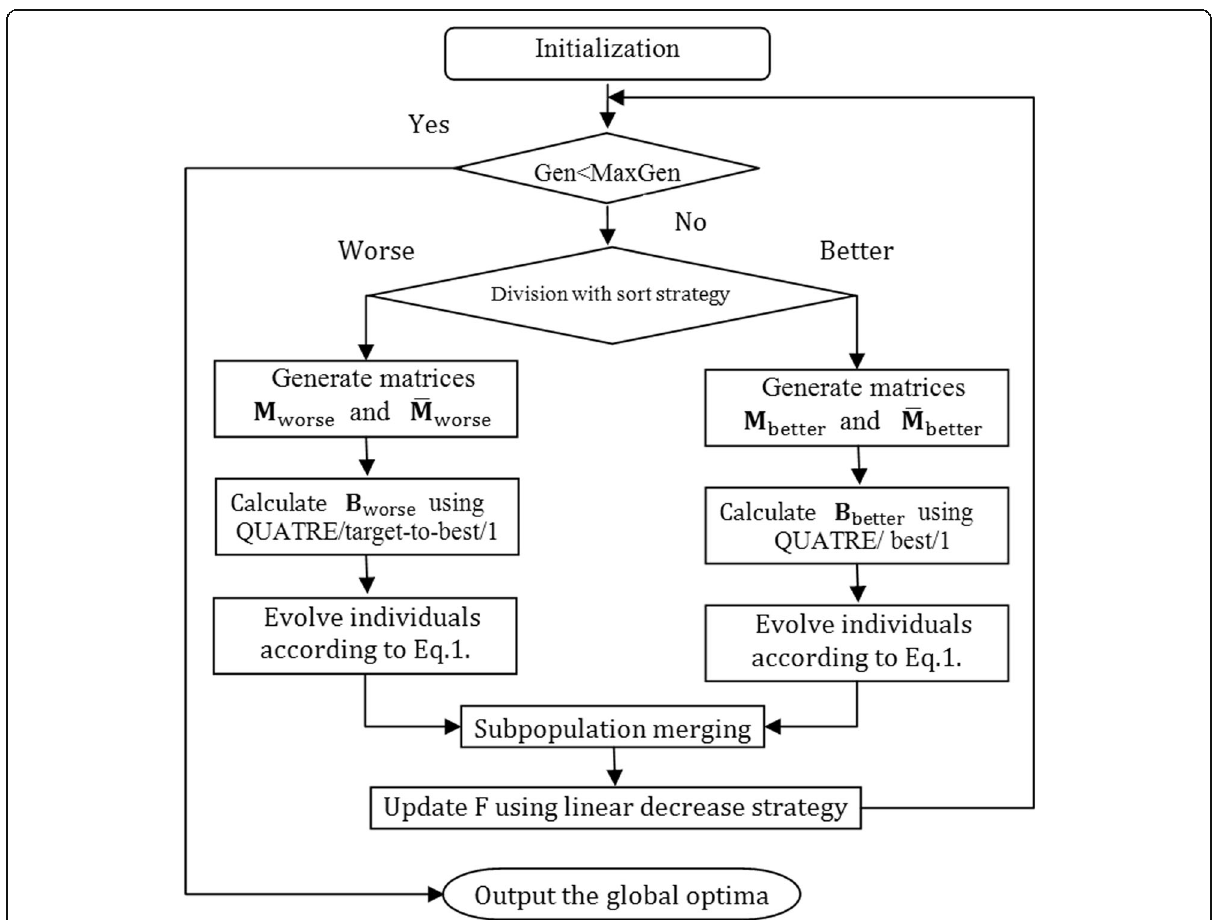
Fig. 1 The main framework of BP-QUATRE. The flowchart of BPQUATRE algorithm consists of population initialization, population division, subpopulation evolution, subpopulation merging and approach of updating parameter scale factor F. Gen is the current generation number and MaxGen is the maximum generation number. Better means the subpopulation with better fitness values (i.e., with the lower fitness values for a minimization problem). Worse means the subpopulation with worse fitness values. The better subpopulation evolves by adopting mutation strategy “ QUATRE/best/1 ” to make good exploitation around the individuals with better fitness values and to have good convergence rate. The worse subpopulation evolves by using mutation strategy “ QUATRE/target-to-best/1 ”